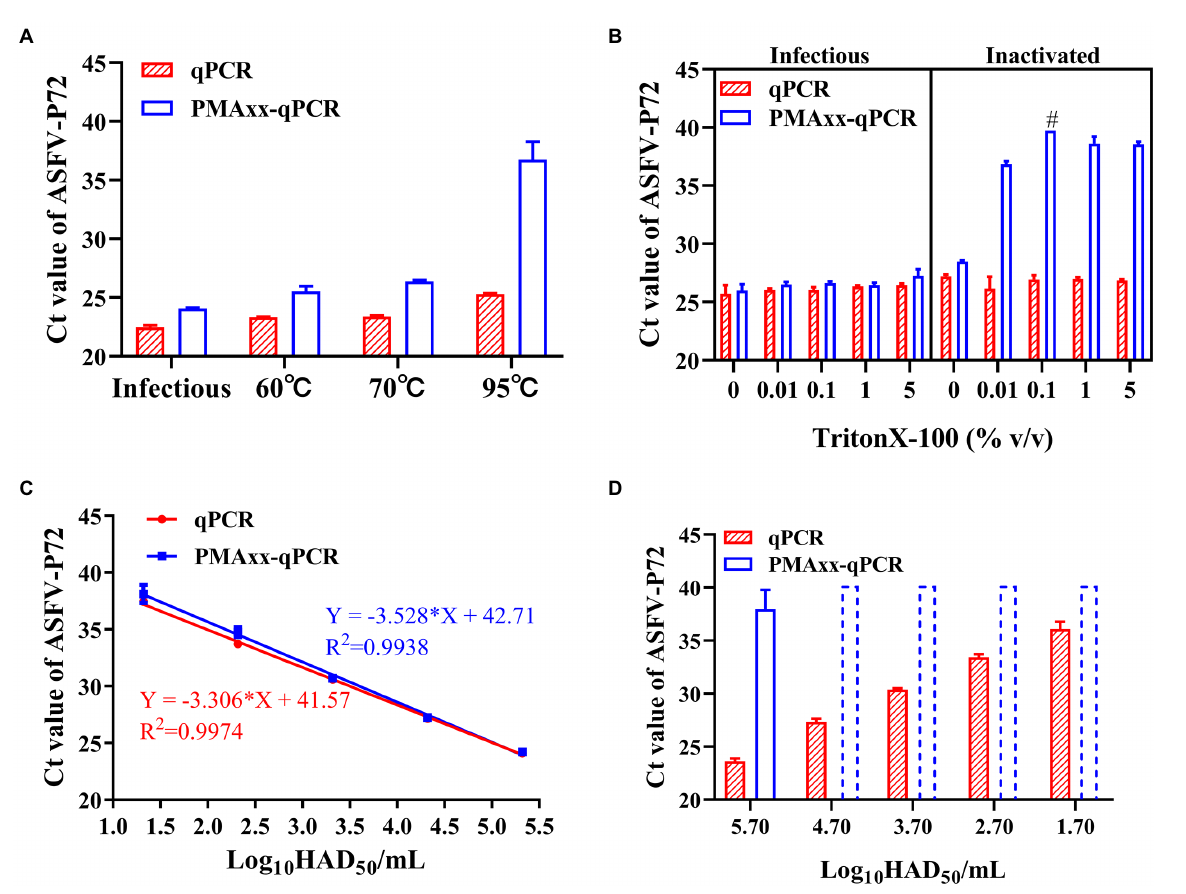
FIGURE 3 Performance of the PMAxx-qPCR assay and the Triton X-100 assisted PMAxx-qPCR assay in detecting infectious ASFV and thermo-inactivated ASFV. (A) Ct values of infectious ASFV and their inactivated counterparts treated at three temperatures (60 ° C, 70 ° C, or 95 ° C) for 20 min and determined by qPCR (without PMAxx) and PMAxx-qPCR. (B) Effects of the Triton X-100 assisted PMAxx-PCR assay in detecting infectious or live ASFV (left) and their counterpart inactivated ASFV at 60 ° C for 20 min (right). (C) Linear curve fitting of the qPCR and the Triton X-100 assisted PMAxx-qPCR assay using serial dilutions of infectious ASFV with 0.1% Triton X-100. (D) Ct values of ASFV samples inactivated at 60 ° C for 20 min and detected using qPCR (without PMAxx) and Triton X-100 assisted PMAxx-qPCR. Dotted plots represent no amplification after 40 cycles and